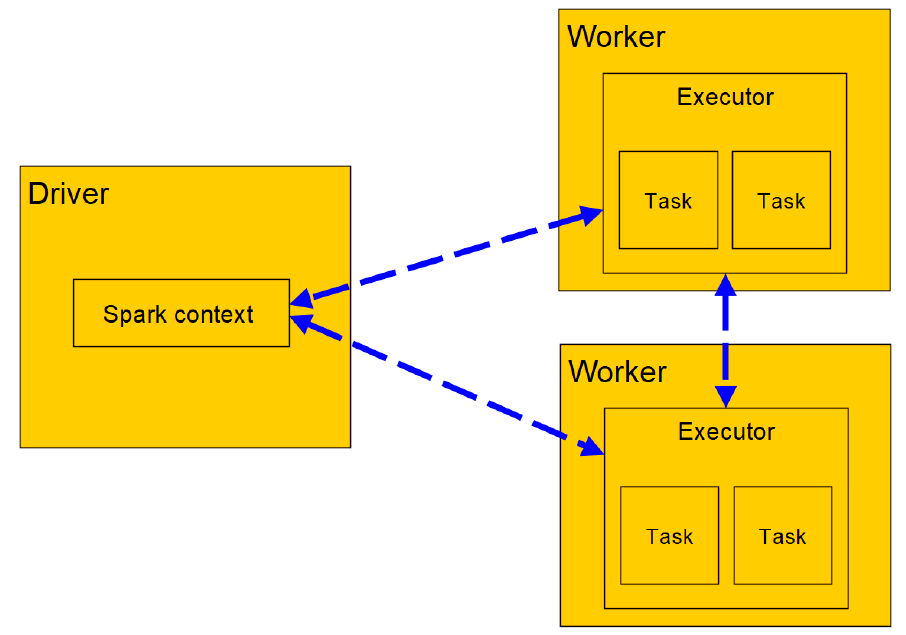
Figure 1. Components of Distributed Execution in Spark.